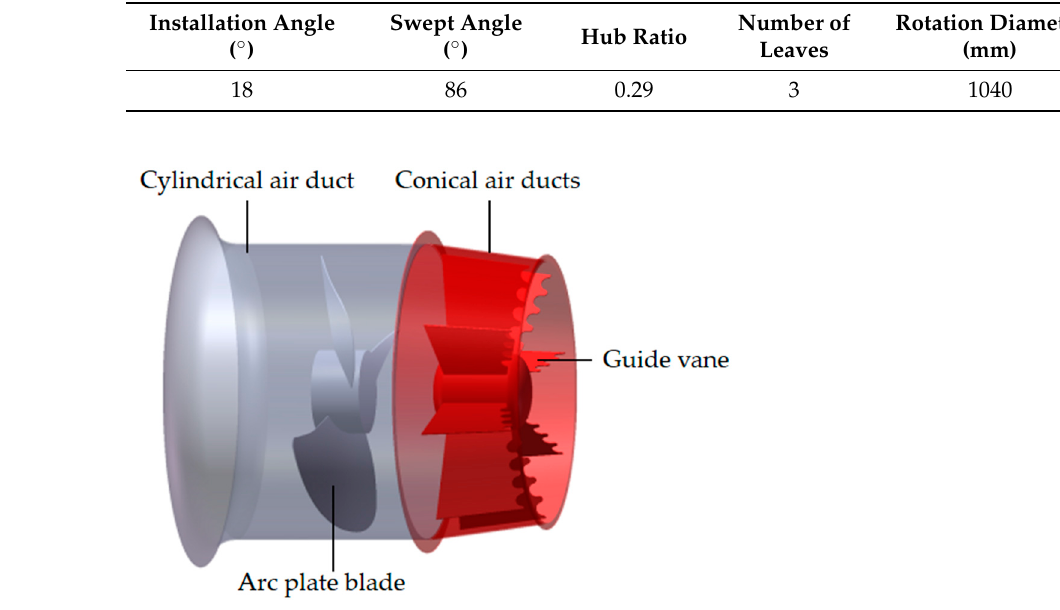
Figure 4. Overall structural design of the air